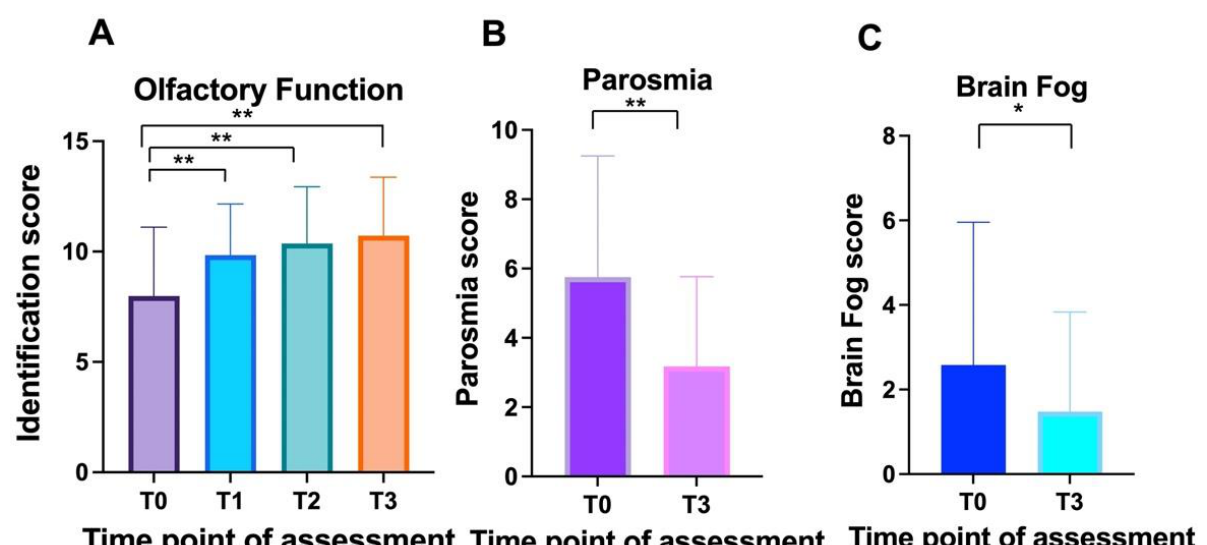
Figure 1. Overall trends in olfactory function, parosmia, and mental clouding in patients receiving PEA-LUT and olfactory training for post-acute sequelae of SARS-CoV-2 infection (“long COVID”): ( A ) smell identification scores at baseline (T0), T1 (1 month), T2 (2 months), and T3 (3 months) for individuals receiving therapy; ( B ) prevalence of parosmia in the cohort before (T0) and after three months of treatment (T3); ( C ) prevalence of mental clouding before (T0) and after three months of treatment (T3). **, p < 0.01; *, p < 0.05.